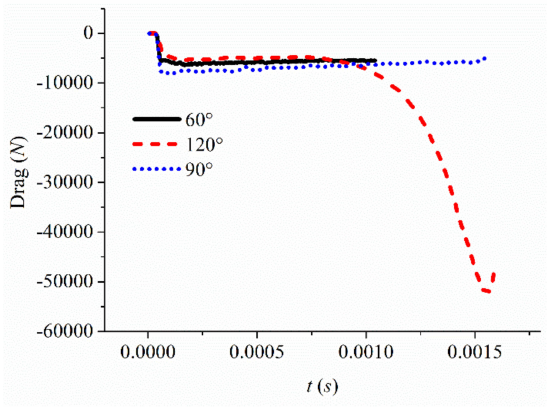
Figure 16. Drag with di ff erent α along the Z